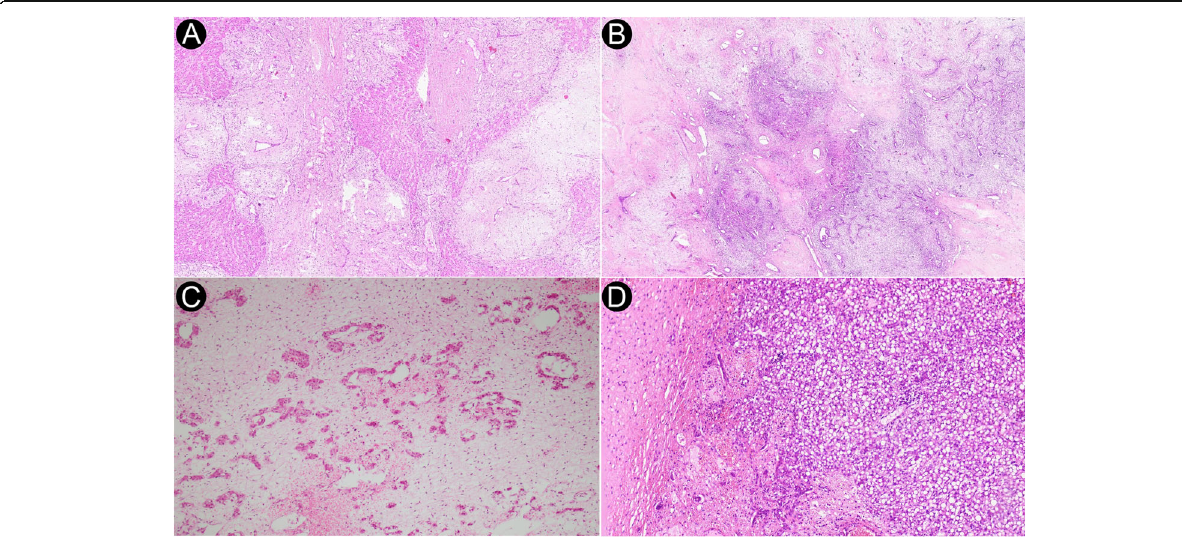
Fig. 2 Histopathologic findings in HMH cases. A Disordered arrangement of hepatic parenchyma, bile ducts, and spindled cells (Hematoxylin and Eosin, 40×). B Disordered arrangement of hepatic parenchyma, bile ducts, and spindled cells (Hematoxylin and Eosin, 20×). C Hepatic parenchyma in myxoid stroma (Hematoxylin and Eosin, 100×). D Severe hepatic steatosis (Hematoxylin and Eosin, 80×)